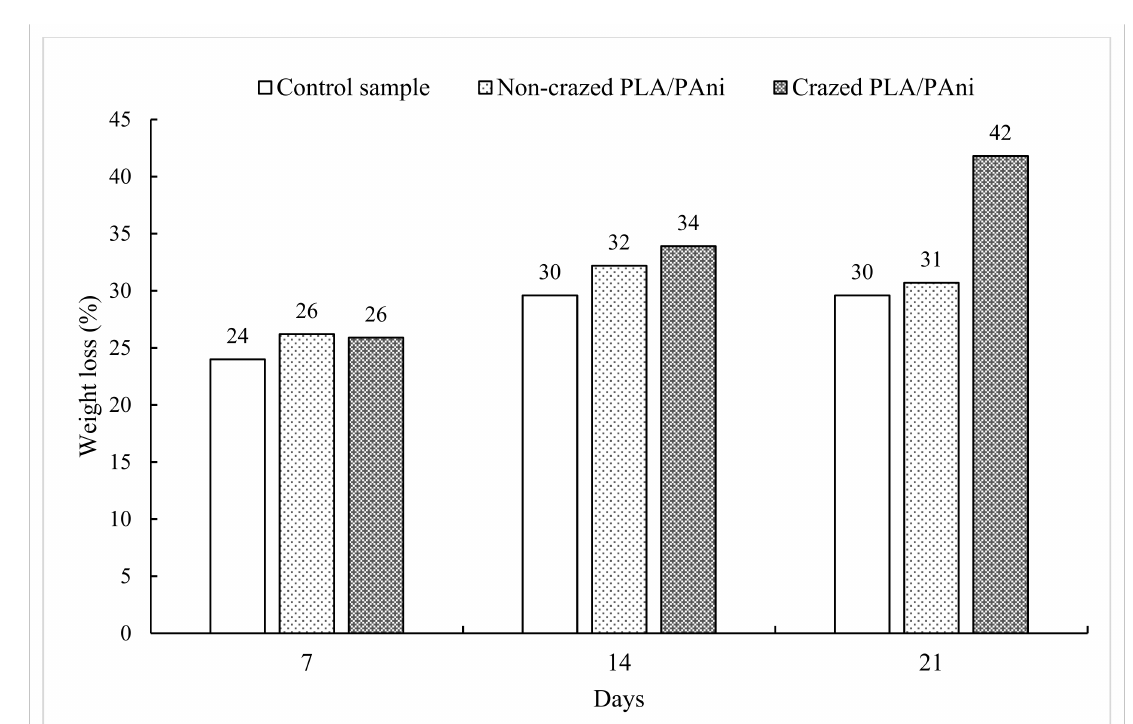
Figure 7. Biodegradation of non-crazed PLA/PAni and crazed PLA/PAni films at different time